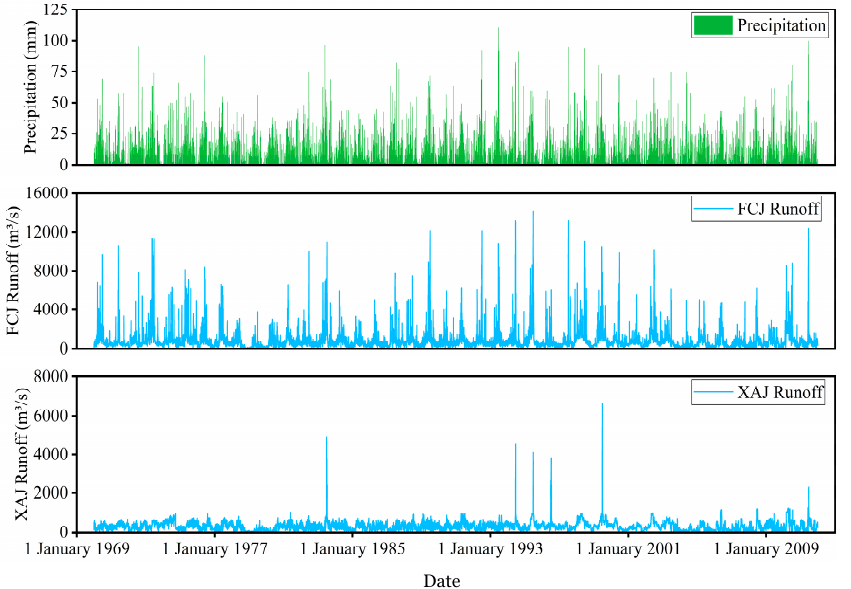
Figure 4. Precipitation and runoff distribution in the Qiantang River basin from 1970 to 2011.